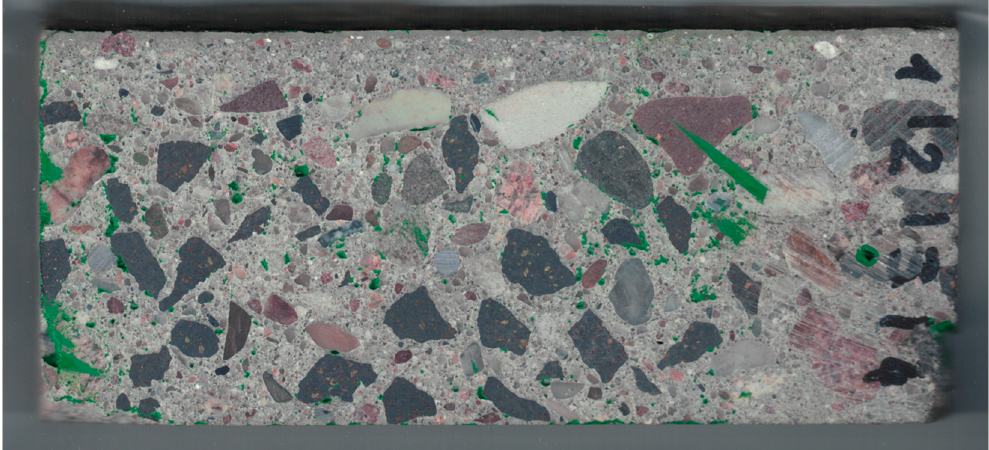
Figure 7. Scan of tested sample after staining the pores.